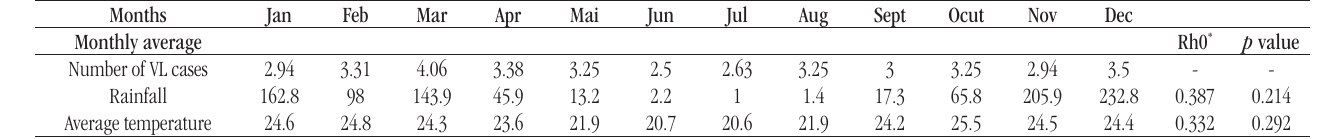
FIGURE 3 – Monthly distribution of VL cases admitted to a referral hospital in the north of Minas Gerais, in addition to monthly averages of average temperature and monthly rainfall, 2007-2016 VL: visceral TABLE 2 – Spearman’s correlation between monthly averages of number of VL cases, average temperature, and rainfall, between 1999 and 2016; HUCF, Montes Claros, Minas Gerais, Brazil